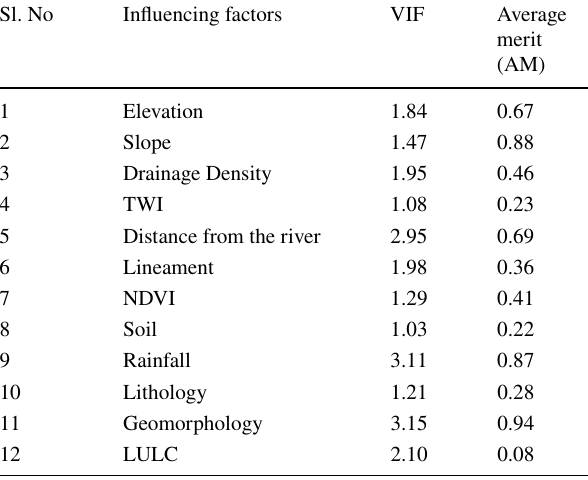
Table 6 The evolution of the influencing factors using VIF and